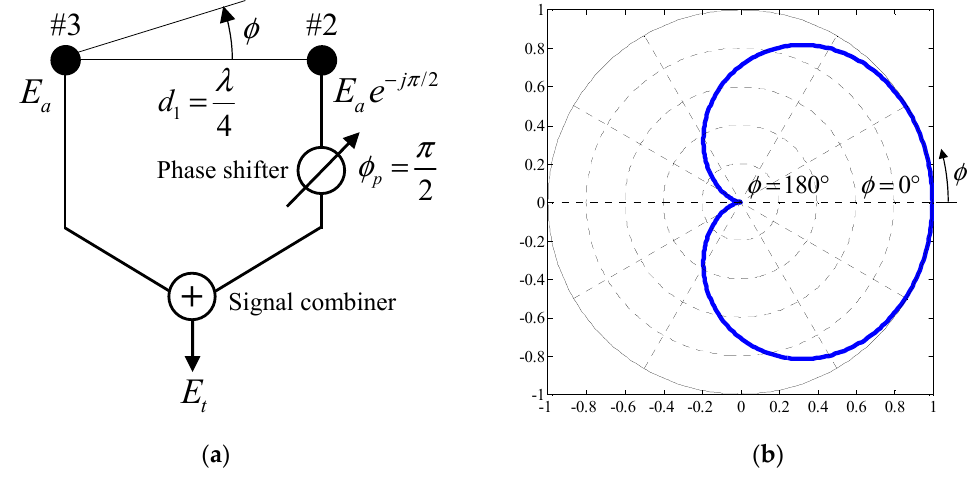
Figure 8. Principle of the cardioid radiation pattern created by two isotropic point sources. ( a ) Figure 8. Principleofthecardioidradiationpatterncreatedbytwoisotropicpointsources. ( a )Configuration Configuration of the array. ( b ) Cardioid radiation pattern. of the array. ( b ) Cardioid radiation